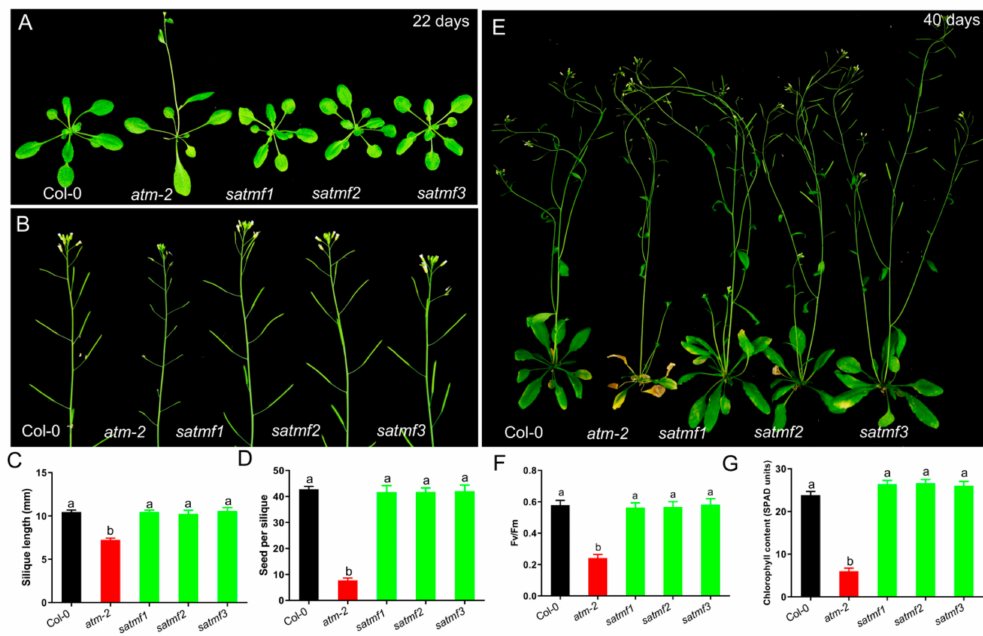
Figure 2. SATMF suppresses the early senescence phenotypes of atm mutant and improves its fertility. ( A ) Rosette leaves of 22-day-old plants of Col-0, atm-2 , satmf1 , satmf2 and satmf3 . ( B ) Fertility of Col-0, atm-2 , satmf1 , satmf2 and satmf3 plants. Silique length ( C ), Number of seeds per silique ( D ), Senescence phenotypes ( E ) of 40-day-old plants of Col-0, atm-2 , satmf1 , satmf2 and satmf3 . ( F ) Photochemical e ffi ciency of PSII (Fv / Fm) and chlorophyll contents ( G ) in the third and fourth leaves of 35-day-old plants of indicated genetic backgrounds. Di ff erent letters represent significant di ff erences (two-way ANOVA and post-hoc Tukey test, p <